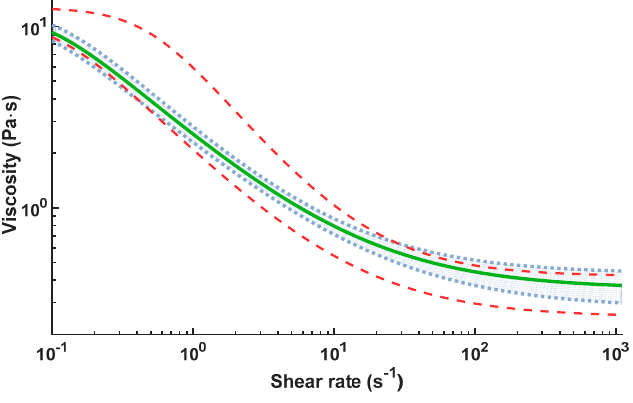
Figure 2. Rheological curves for the system under study. The shaded region indicates the viscosity values for in-control product. The red dotted lines are examples of off-control products.